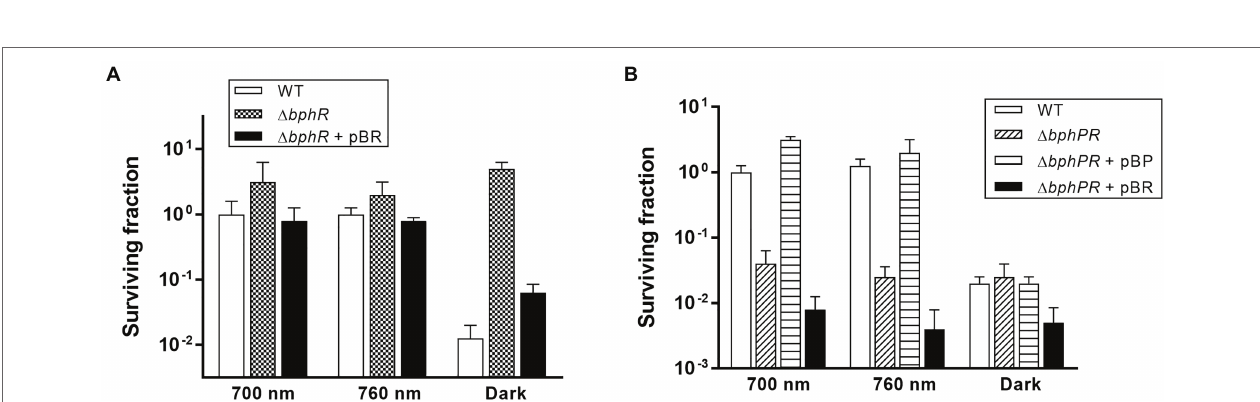
FIGURE 5 | Survival and complementation of Δ bphR (A) and Δ bphPR (B) . Deinococcus radiodurans wild-type, bphR , and bphPR mutant strains were grown to log phase, then serially diluted, and spotted on TGY plates supplemented with 300 nM MMC. The plasmids pBR and pBP, which carries the bphR and bphP genes, respectively, were used for the complementation assay. The plates were incubated under red light (700 nm), far-red light (760 nm), or no light (dark) conditions for 2 days prior to the enumeration of colonies. The surviving fraction was expressed relative to 700 nm-grown WT survival (arbitrarily set at 1). The error bars represent the SD of three independent experiments ( n = 3).